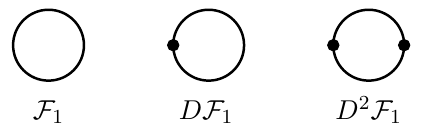
Figure 1 . Diagrammatic representation of the identity (2.23).